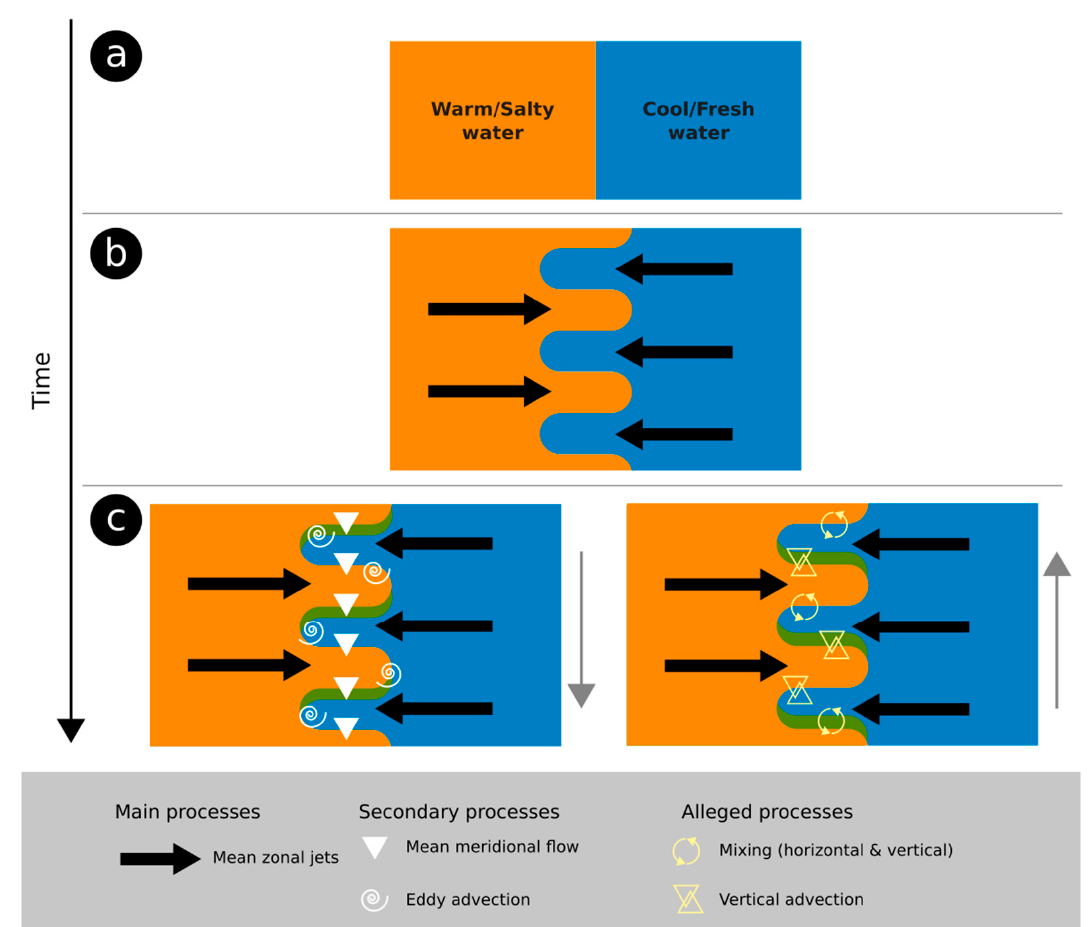
Figure 10. Conceptual model for the time-averaged impact of striations on SST and SSS in the ENP. ( a ) Initial state: large-scale zonal gradient between the cooler and fresher surface waters of the California upwelling system and the warmer and saltier waters of the North Pacific subtropical gyre. ( b ) Main process: multiple time-mean zonal jets advect the background SST and SSS gradients, rapidly generating striated tracer anomalies in the form of alternating mesoscale zonal fronts. ( c ) Secondary and alleged processes: (left) the large-scale meridional flow acts to displace the mesoscale tracer pattern equatorward (grey arrow directed southward and green areas to the south of the warm/salty tongues) by advecting warm/salty and cool/fresh waters across the fronts on their southern flanks, with additional contributions from eddy advection; (right) vertical advection, horizontal and vertical mixing likely balance the aforementioned processes, through the compensating poleward shift of tracer anomalies (grey arrow directed northward and green areas to the north of the warm/salty tongues) and the dissipation of the striated SST/SSS anomalies originally generated through zonal advection.